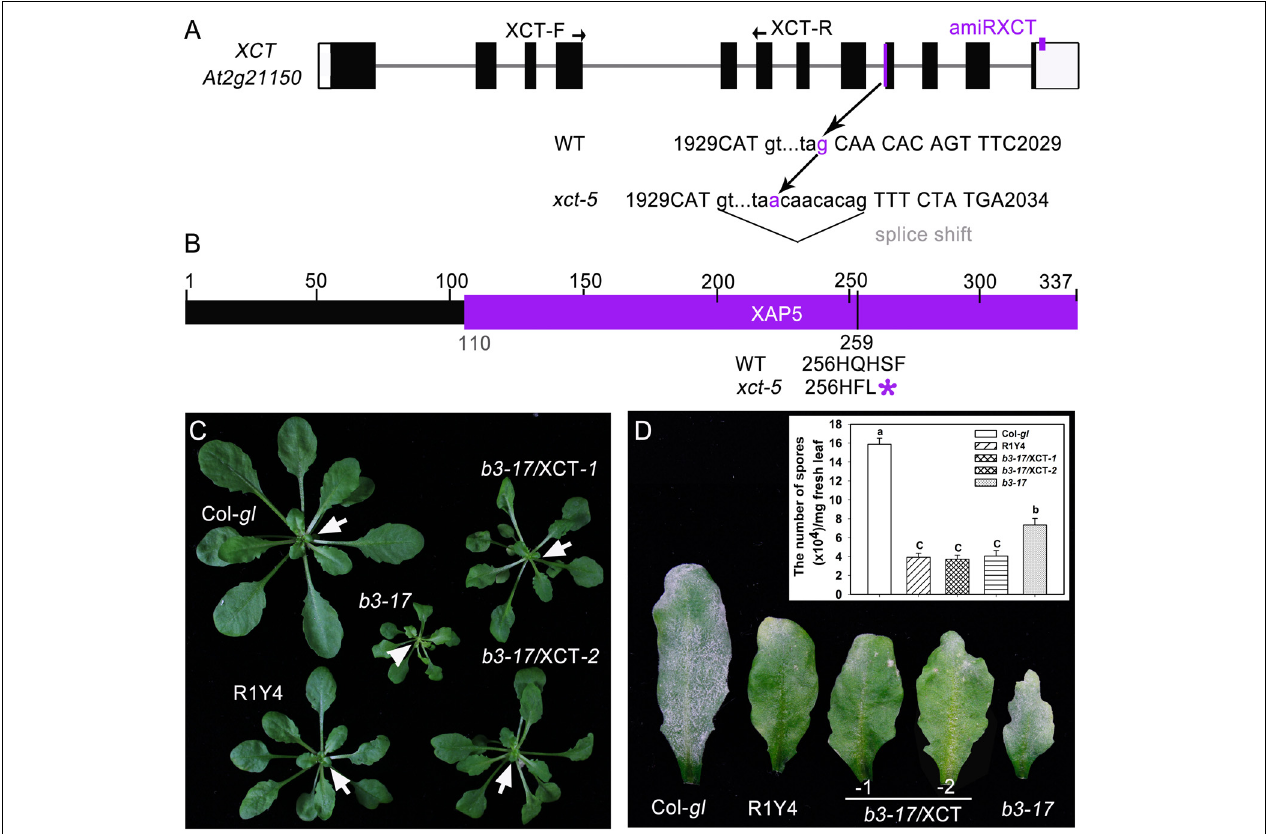
FIGURE 2 | The b3-17 mutant contains a novel allele of XCT. (A) Schematic gene structure of XCT ( At2g21150 ) and the position of the mutation site in b3-17 . XCT-F and XCT-R indicate the position of primers for quantitative RT-PCR (qRT-PCR). A small purple box indicates the target site of artificial microRNA at the 3 (cid:48) -untranslated region. (B) Predicted protein structure of XCT and the stop codon introduced by the mutation in b3-17 was indicated ( ∗ ). The purple bar represents the X-chromosome Associated Protein 5 (XAP5) domain. (C,D) Representative plants (C) and leaves (D) of the indicated lines show the phenotypic complementation before (C) and after (D) inoculation of powdery mildew. b3-17 /XCT indicates the complemented lines by introduction of the wild type XCT gene into the b3-17 mutant. Note the freshly emerged light-green leaf (arrowhead) in the b3-17 mutant in comparison with the green ones (arrows) in the other lines. Inset in (D) shows quantification analysis on sporulation of powdery mildew from the indicated lines. Error bars indicate SD ( n = 3). Different letters above the bars indicate significant differences at P < 0.01. Similar results were obtained in two independent